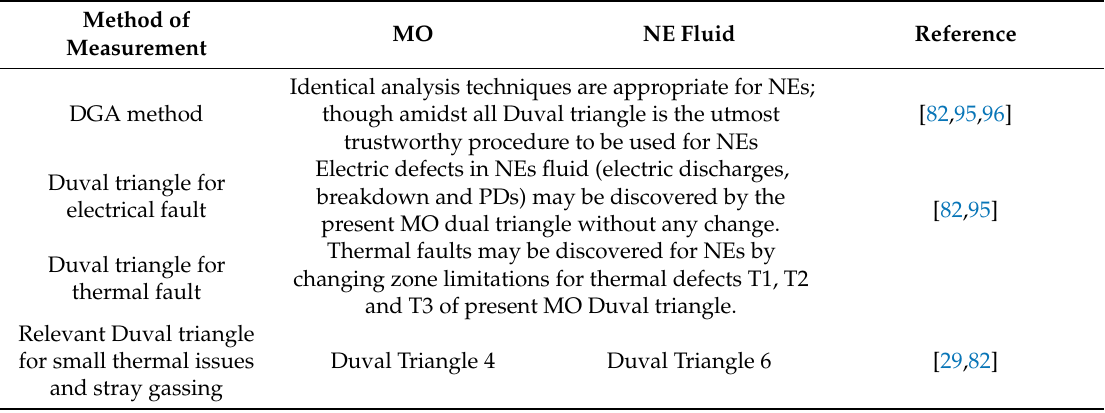
Table 16. Dissolved gas analysis (DGA) exploration methods of dielectric